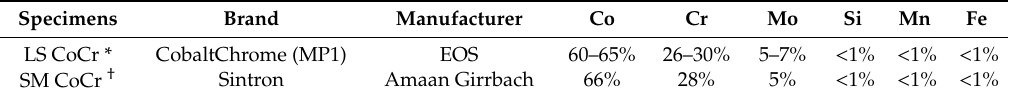
Table 1. Composition of CoCr powder used in each manufacturing